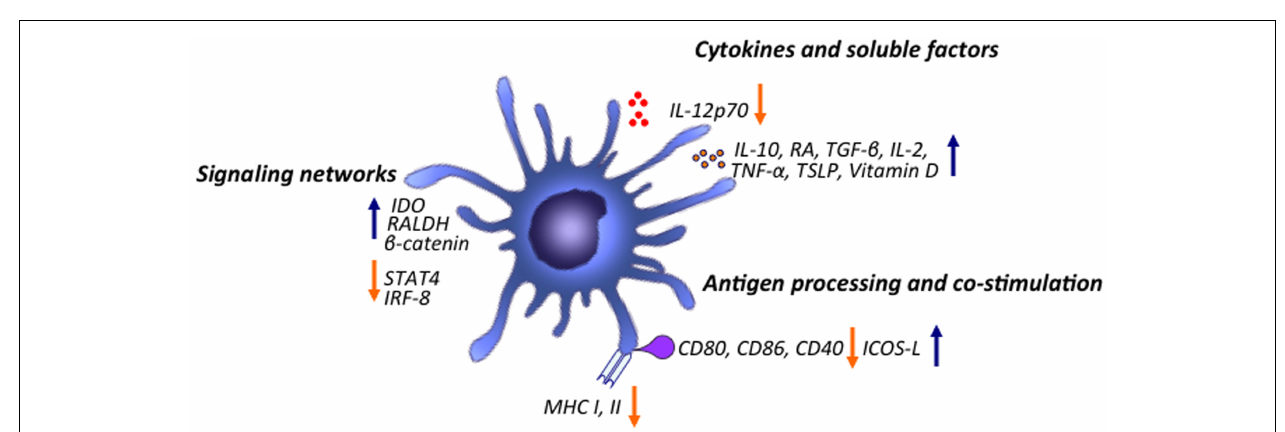
T reg cells and DCs, and limits the access ofT eff cells to DCs. Expression of LFA-1 onT reg cells, promotes aggregate formation around DCs, and inhibit the up-regulation of CD80 and CD86 on DCs. IL-10 inhibits up-regulation of MHCI/II and B7 co-stimulatory molecule expression, suppresses release of pro-inflammatory cytokines such as IL-1 β , IL-6, TNF- α , and IL-12, and up-regulates of B7-H4 and B7-H inhibitory molecules.